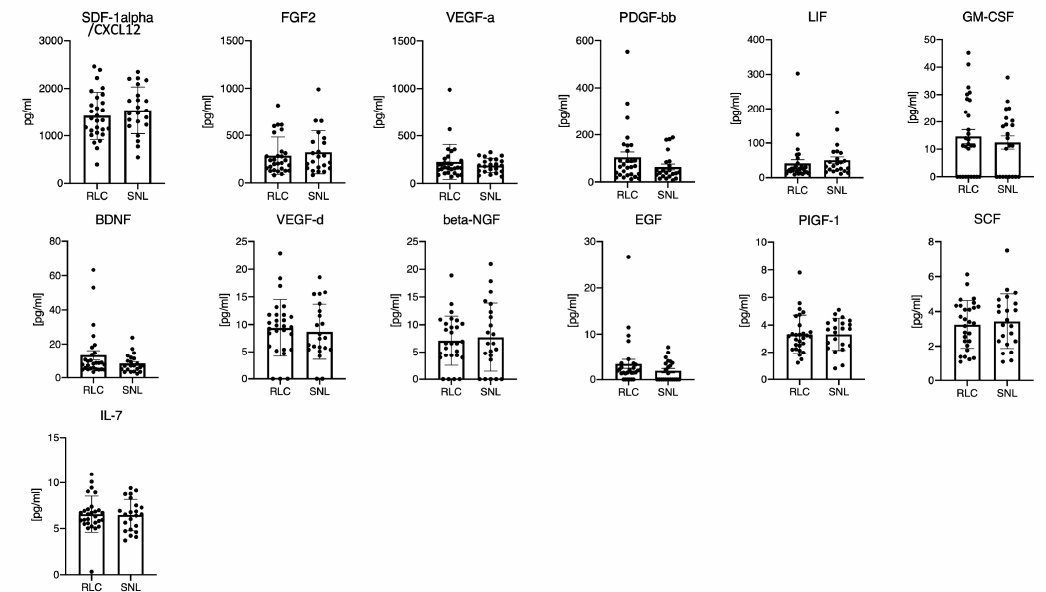
Figure 1. The protein microenvironment of 13 different growth factors in the livers of BA patients does not enable differentiation of clinical outcome. Legend: Multiplex measurement of 13 different growth factors from homogenized liver tissues of BA patients with favorable (SNL) or unfavorable course of disease (RLC). Each mark represents the value of an individual patient in the RLC or SNL group. The bar graph depicts the group mean; the error bar depicts the SD. Unpaired t -test yielded no statistically significant differences.